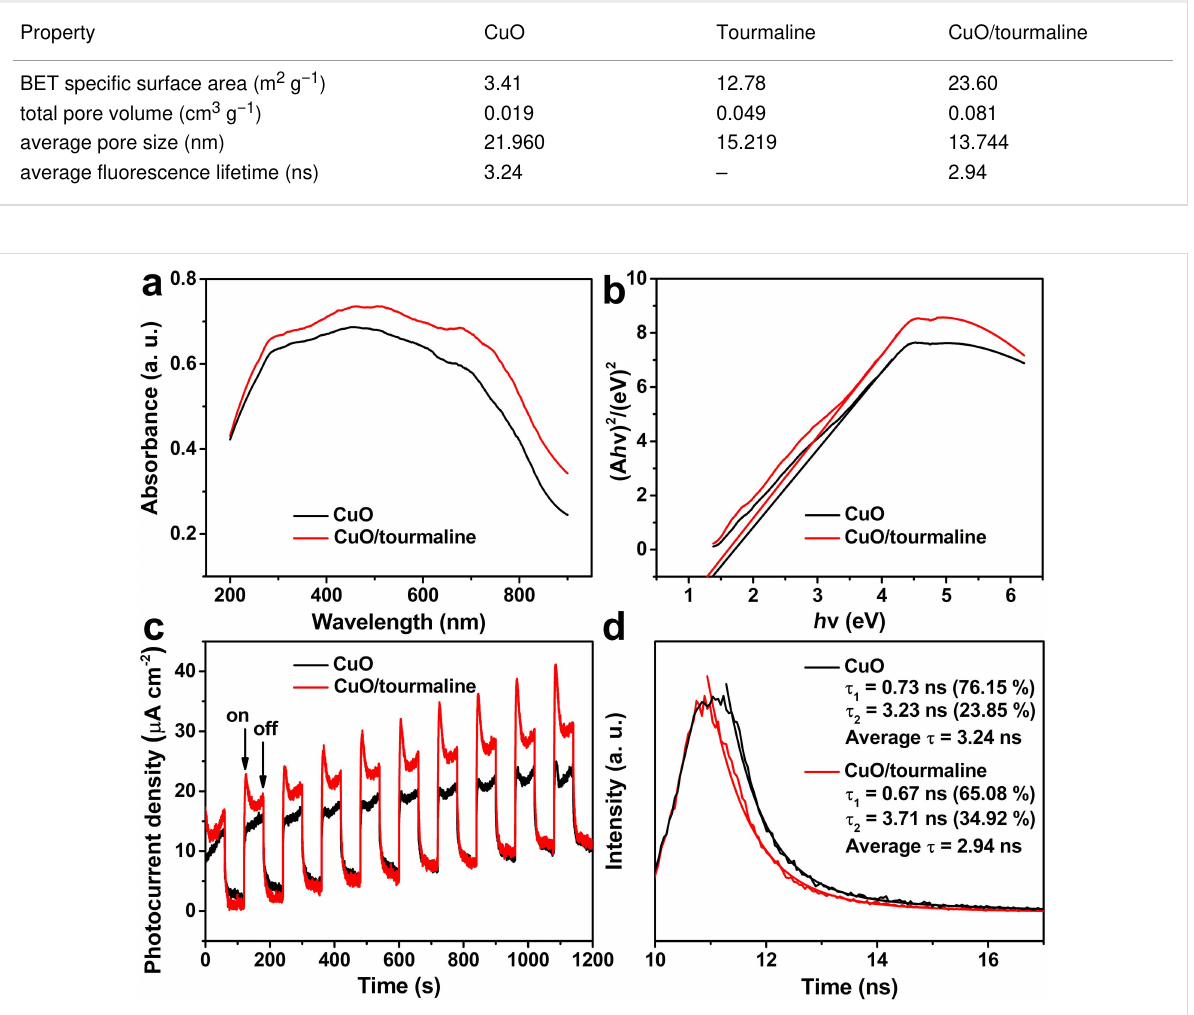
Figure 5: (a) UV–vis diffuse reflectance spectra, (b) plots of (A h ν ) 2 vs h ν , (c) transient photocurrent, and (d) time-resolved PL spectra of the CuO and CuO/tourmaline composite.